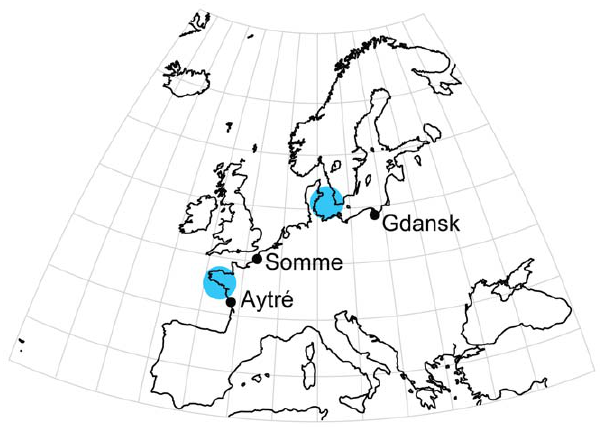
Figure 7. Sampling locations of the three population pools used for SNP discovery in Macomabalthica . Orthogonal projection with 10 degree grid. The positions of contact zones among differentiated mitochondrial lineages are indicated as blue circles (after [16,72]).